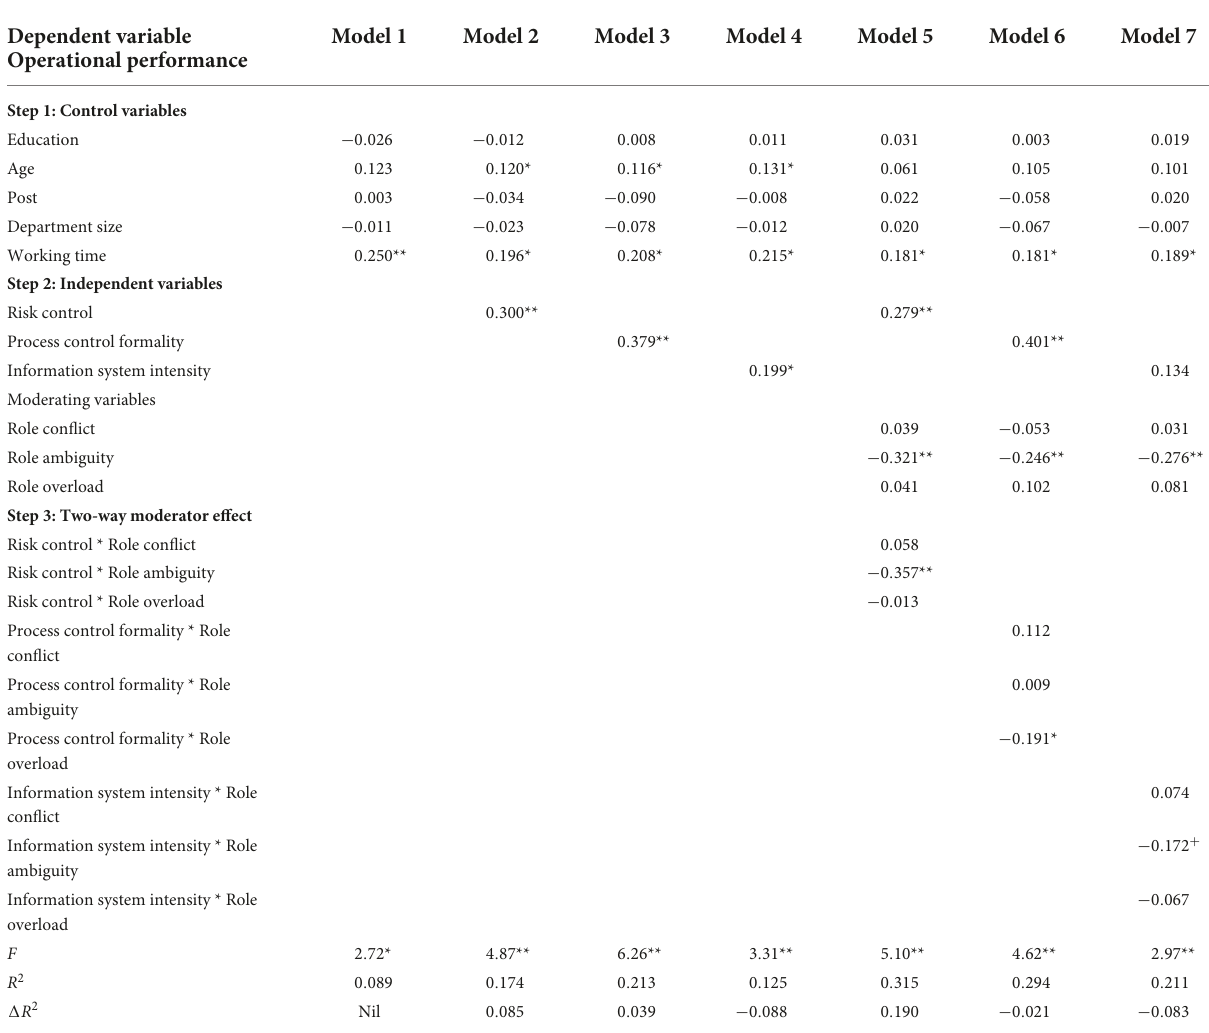
TABLE 6 Hierarchical regression results for Hypotheses